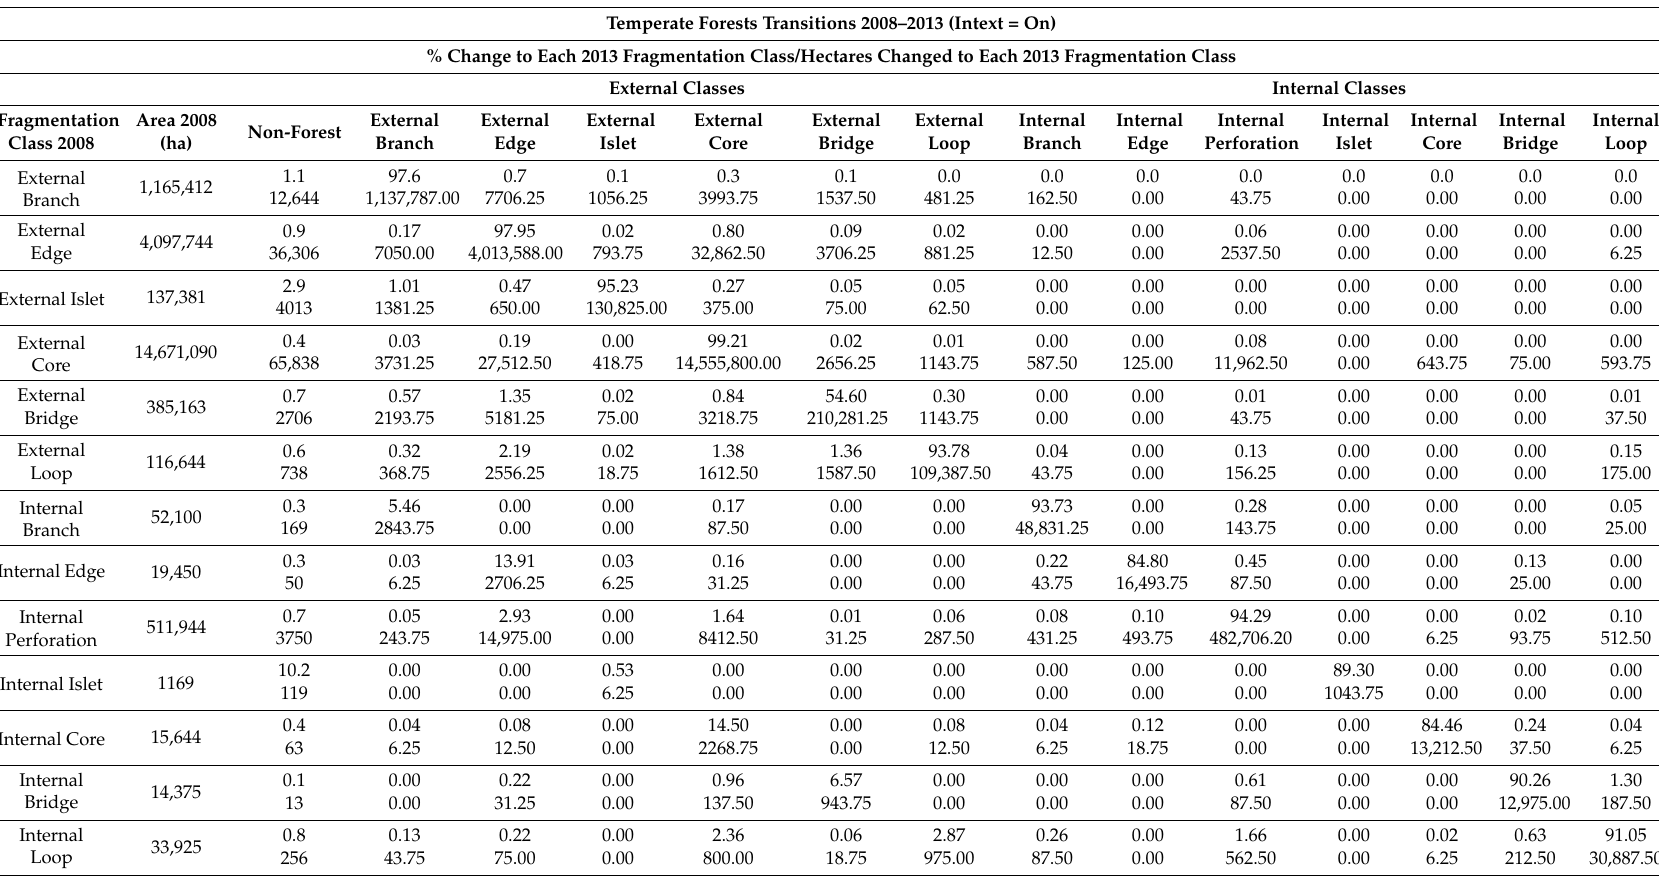
Table E2. Fragmentation classes transition matrix temperate forests in the 2008–2013 period differentiating between internal and external fragmentation classes. Temperate Forests Transitions 2008–2013 (Intext = On) % Change to Each 2013 Fragmentation Class/Hectares Changed to Each 2013 Fragmentation